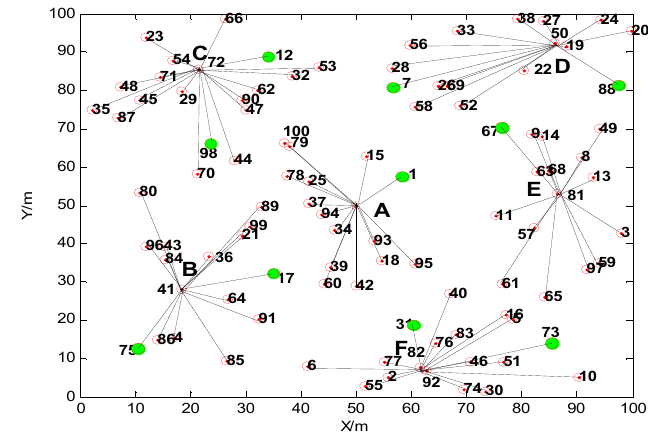
Sensors 2015 , 15 Figure 6. The structure of network after the movement of 10% of the nodes. Figure 6. The structure of network after the movement of 10% of the nodes. Figure 6. The structure of network after the movement of 10% of the nodes.